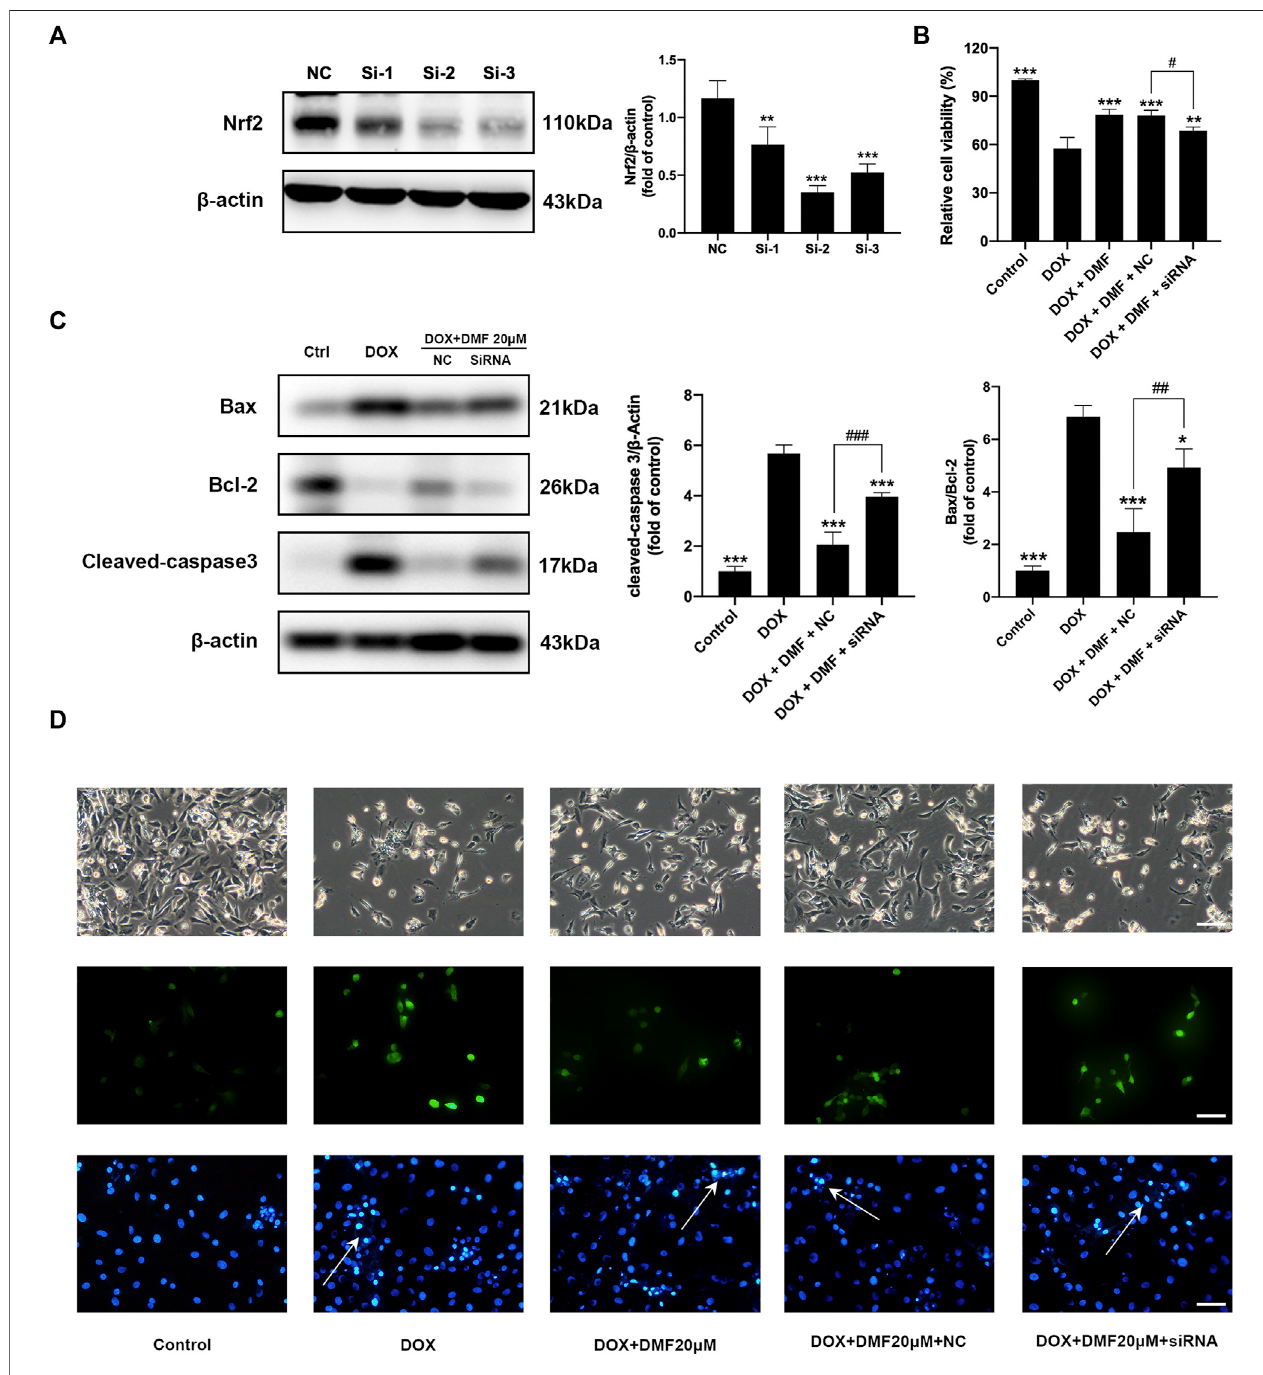
FIGURE 6 | Nrf2 silencing reversed the protective effects of DMF on DOX-induced NRCMs injury. (A) Representative WB images and quantitative analysis Nrf2 expression in NRCMs after siRNA transfection ( n = 5). (B) Changes in cell viability in NRCMs ( n = 4). (C) Representative WB images and quantitative analysis Bax/Bcl-2 ratio and cleaved caspase-3 expression in NRCMs ( n = 5). (D) Changes in cell morphology ( n = 5), ROS levels ( n = 5), and Hoechst 33258 staining in NRCMs (White arrows indicate apoptotic cells, n = 5, scale bar = 50 μ m). All data were expressed by mean ± SD. * p < 0.05, ** p < 0.01, *** p < 0.001, compared with DOX or NC group. # p < 0.05, ## p < 0.01, ### p < 0.001 compared with DOX + DMF + NC